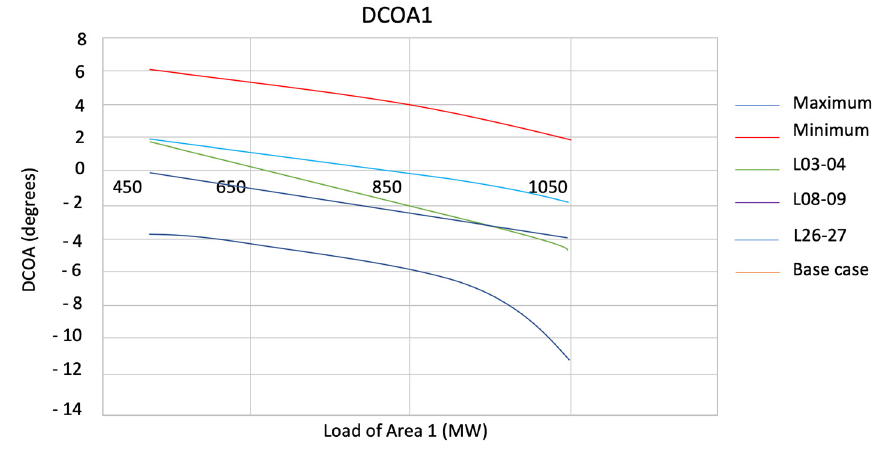
Figure 10. Angular characterization for contingencies N-1 in operational area 1.